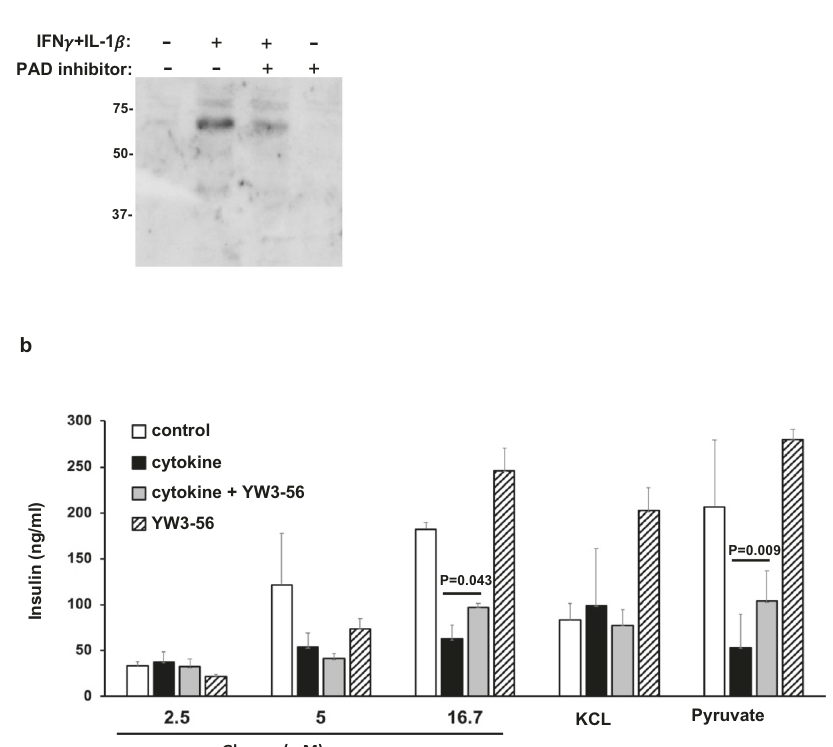
Fig. 4 PAD inhibitor reduces overall citrulline modi fi cation and partially restores cytokine mediated defective insulin secretion in INS-1E beta cells. a INS-1E cells were cultured with IFN γ (100U/ml) plus IL-1 β (5U/ml) in the presence or absence of YW3-56 for 48 hrs, as indicated. Cell lysates were subjected to electrophoresis and followed by immunoblot with anti-modi fi ed citrulline. b As above, INS-1E cells were cultured with IFN γ plus IL-1 β for 48 hrs (black and grey bar). INS-1E cells were stimulated with glucose, KCl or pyruvate for one hr in the absence (white and black bar) or presence of YW3-56 (grey and striped bar) followed by insulin measurement (described in Methods). Data are representative of three independent experiments and the error bars indicated SD of mean. Statistical analysis was performed using Student ’ s t